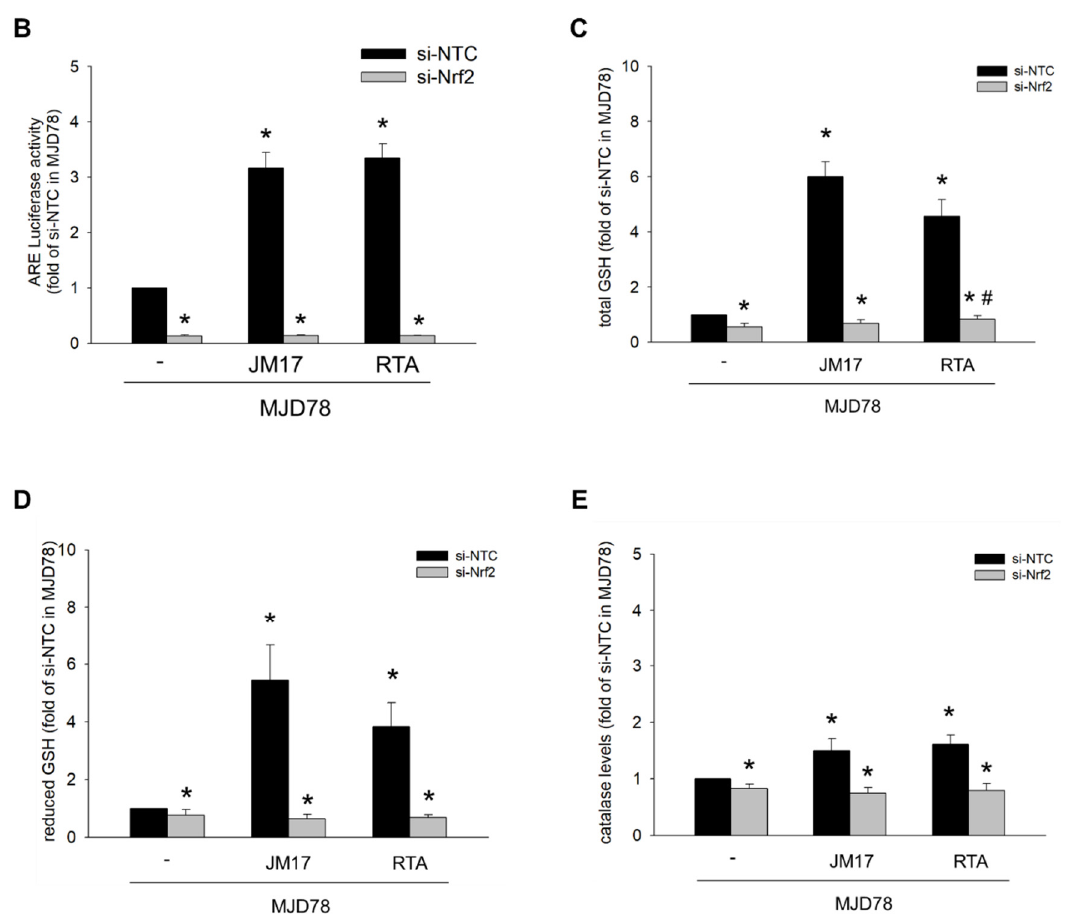
Figure 5. Nrf2 activation-dependent regulation in raising antioxidation and decreasing mutant ataxin-3 expression. MJD78 cells were transiently transfected with si-NTC or si-Nrf2 and with or without an ARE-luciferase reporter construct for 16 h. They were then treated with or without DMSO vehicle, 1 µ M JM17 and 0.3 µ M RTA-408 for 24 h, respectively. ( A ) Protein expression of Nrf2, NQO1, HO-1, SOD1, SOD2 and mutant and normal ataxin3. Levels of ( B ) ARE luciferase activity, ( C ) total GSH, ( D ) reduced GSH and ( E ) catalase are analyzed after treatments. Data are presented as the mean ± SD of at least three independent experiments. Values from the treated cells were normalized to those of the MJD78 cells treated with si-NTC transfection vehicle only. * p < 0.05, compare to non-treated MJD78 with si-NTC group; # p < 0.05, compare to non-treated MJD78 with si-Nrf2 group.